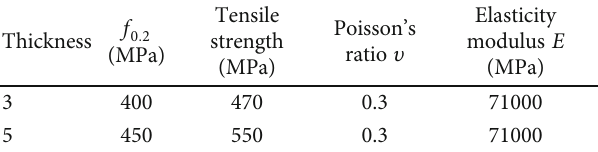
Table 3: Mechanical properties of aluminum alloy material.